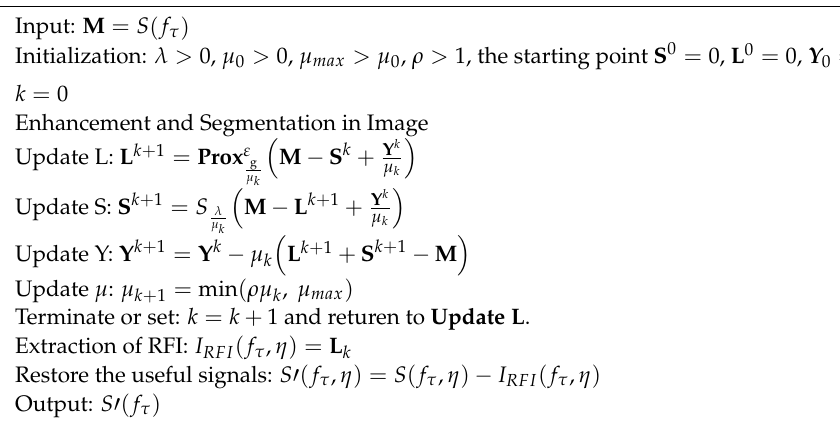
Algorithm 1. A Modified 2-D Notch Filter Based on Image